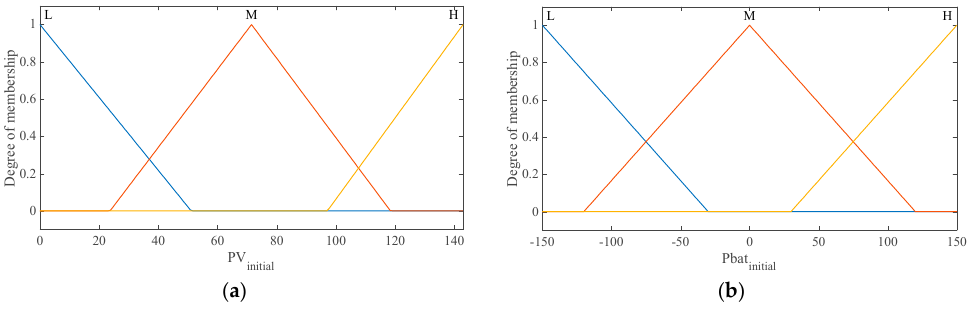
Figure 7. Membership function of the outputs. ( a ) Function of the initial output power of solar energy; ( b ) Function of the initial output power of battery.